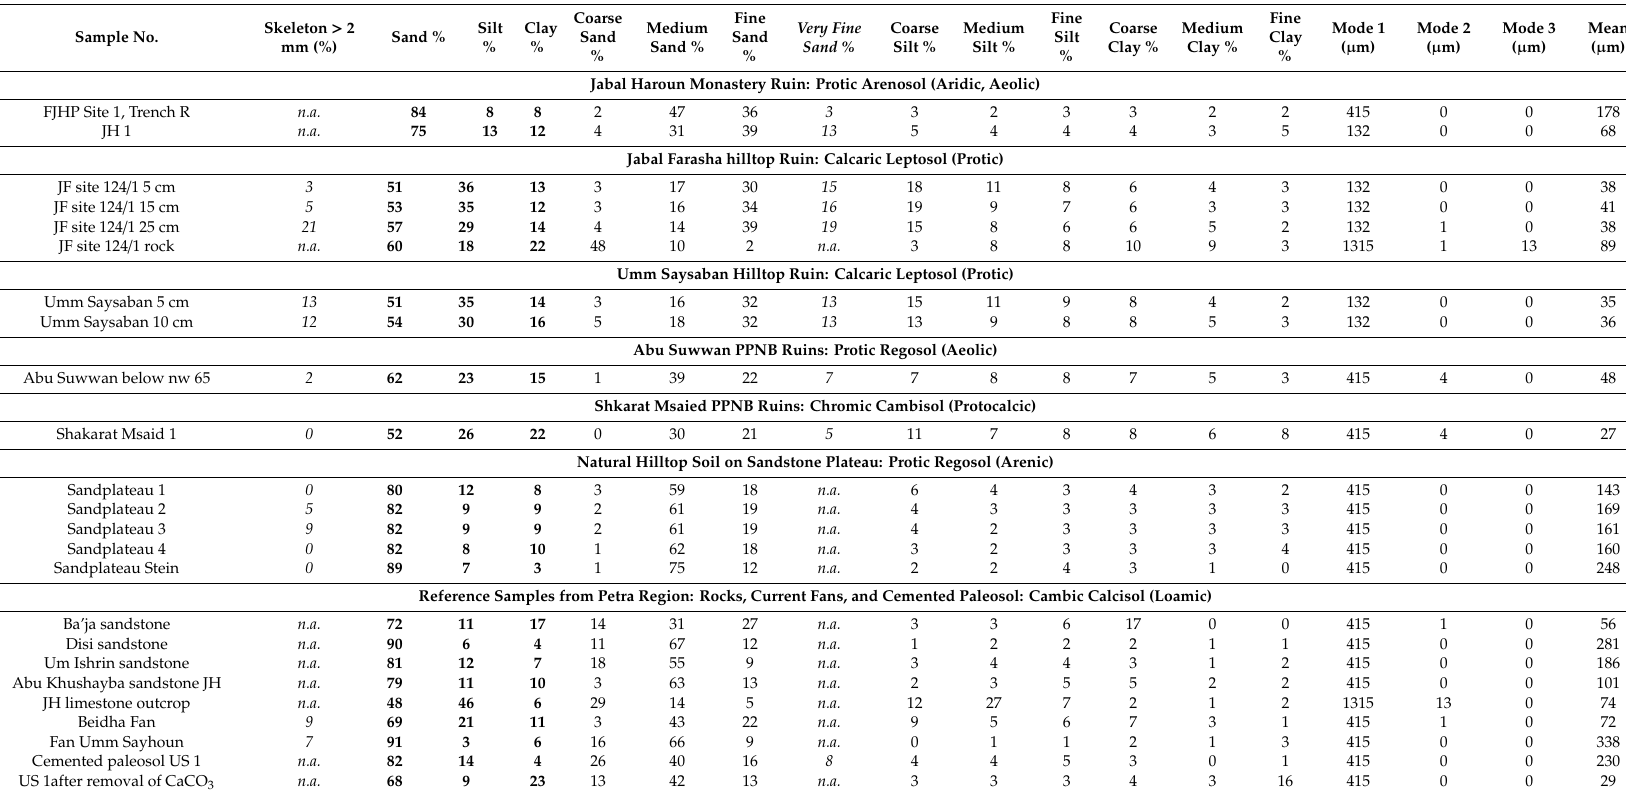
Table A3. Results of particle size analysis of the samples from the Petra region by sieving and Sedigraph and respective statistical parameters. Note that the very fine sand (in italics) is part of the fine sand fraction. Skeleton is shown as well (in italics), and summarizing grain size units (in bold). Sample